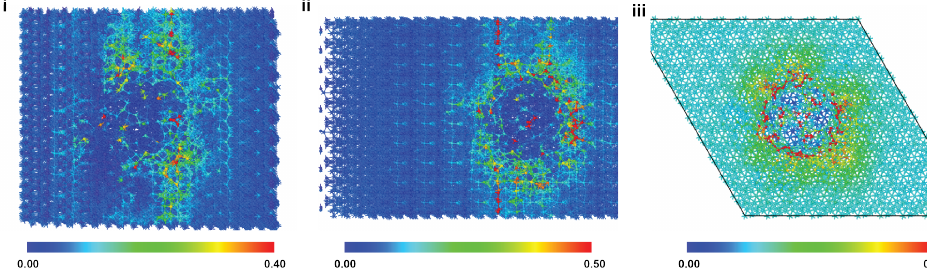
Figure 3. Atomic snapshots of HAP models containing 30 Å pores at the inception of tensile failure for X ( i ), Y ( ii ), and Z ( iii ) loading. Atoms are colored according to the atomic shear strain. X and Y loading images are viewed in the X-Y plane, whereas the Z loading image is in the Y-Z